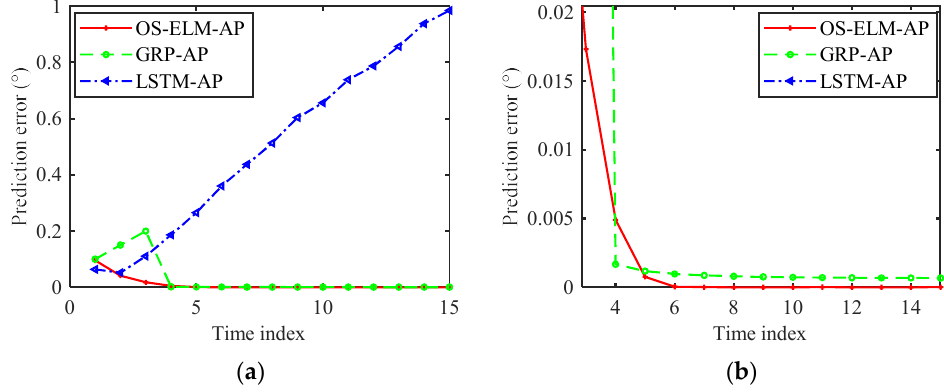
Figure 14. Online angle prediction errors for Path 2. ( a ) Prediction errors. ( b ) Magnified view of ( a ).